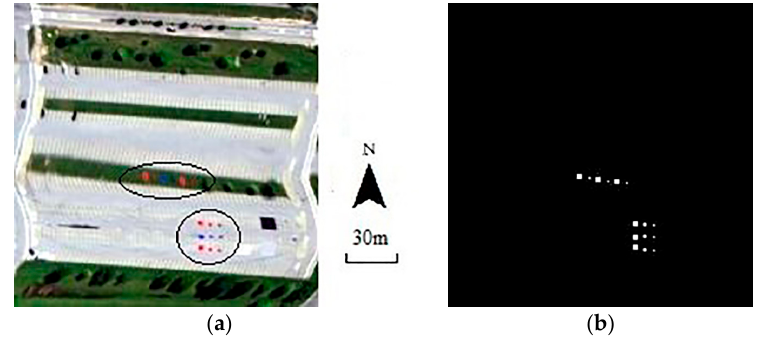
Figure 2. ( a ) The SpecTIR hyperspectral image. The anomalies were highlighted by black ellipses; ( b ) Ground-truth information of the